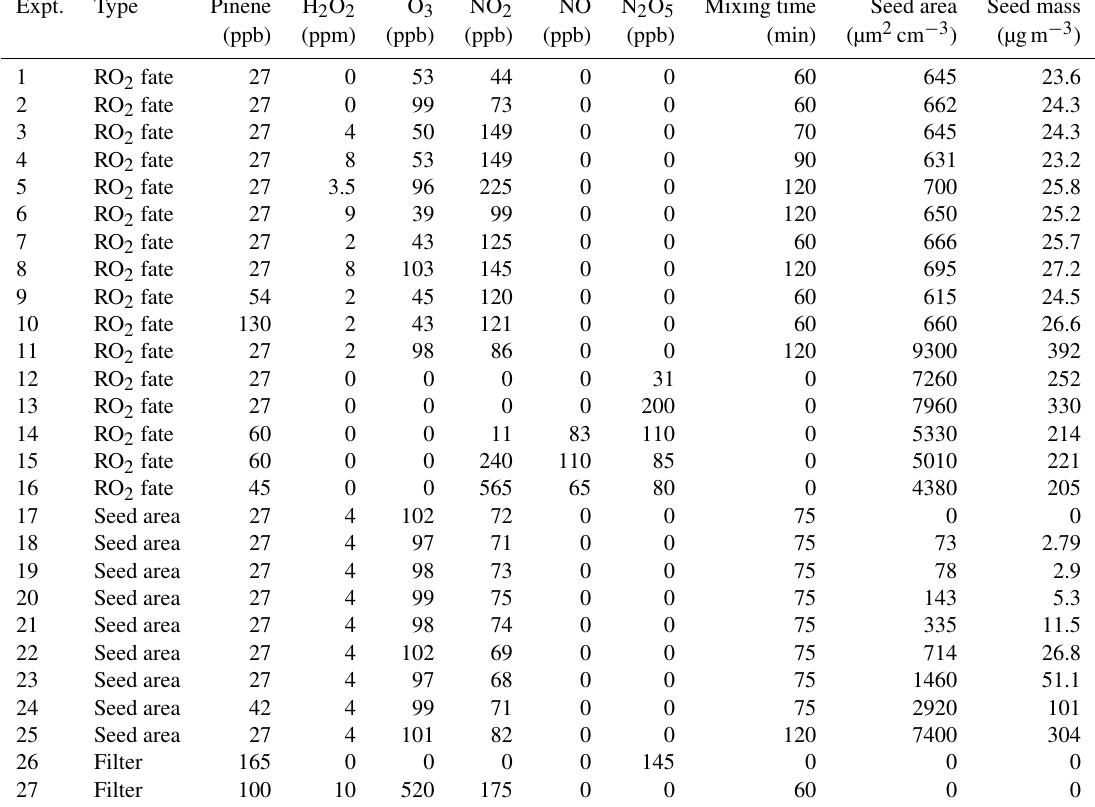
Table 1. Initial conditions for chamber experiments performed in this work. Controls to subtract SOA yields from background chemistry (not listed here) were conducted for experiments 1–11 and 17–25 using identical conditions but omitting NO 2 .